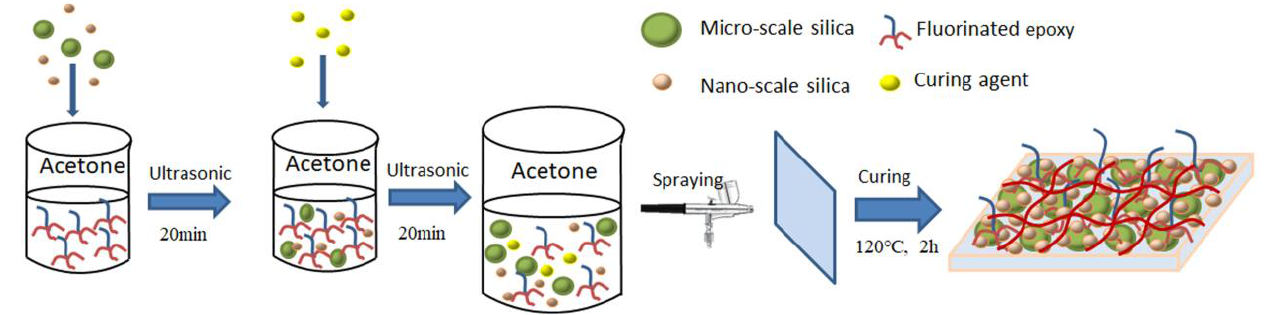
Figure 2. Scheme for preparation of coating by spraying.